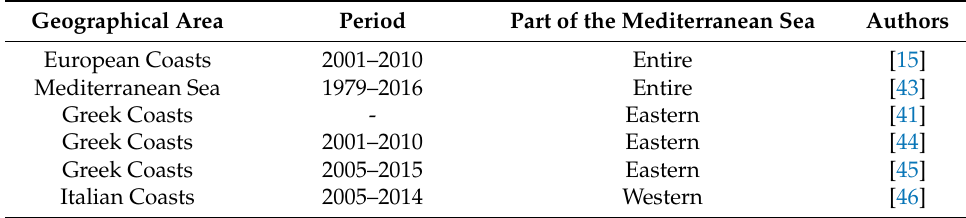
Table 2. Wave and wind energy resource assessment in the Mediterranean